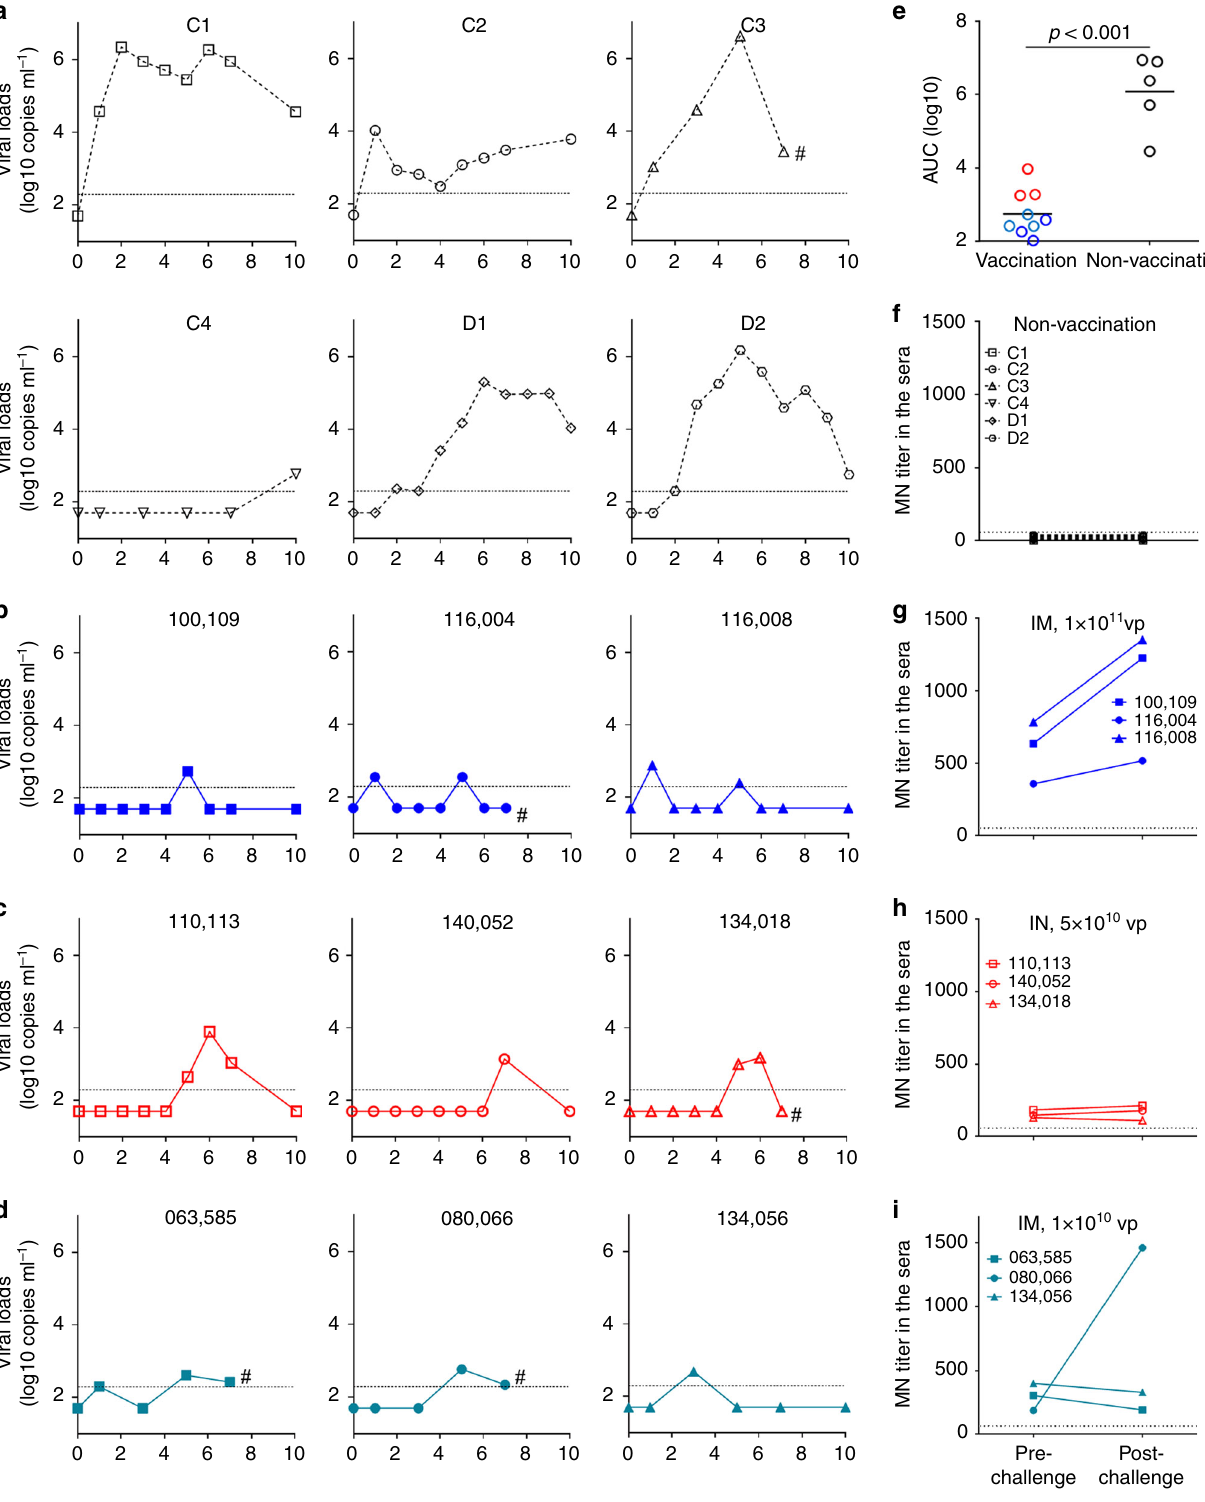
1:784 for macaque No. 100109, No. 116004, and No.116008, respectively. On day 7 after challenge, the neutralizing antibody titers slightly increased (less than 2-folds) with IC50 at 1:1225, 1:518 and 1:1350 for macaque No. 100109, No. 116004, and No.116008 respectively, indicating no or a weak booster effect from the challenge (Fig. 4g). The three IN vaccinated macaques had lower serum neutralizing antibody titers before